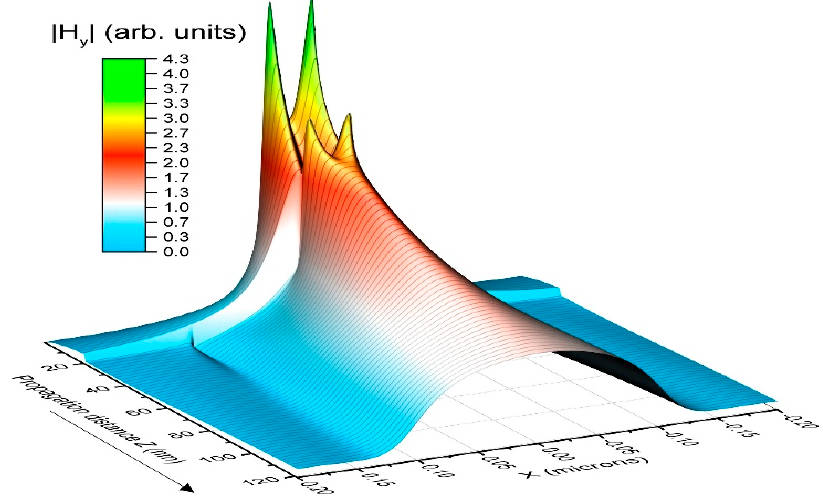
Figure 6. Evolution of the magnetic field H y of the fundamental mode in the plasmonic guide as it propagates towards the silicon guide where the symmetric TM 0 mode is well established after almost 100 nm.